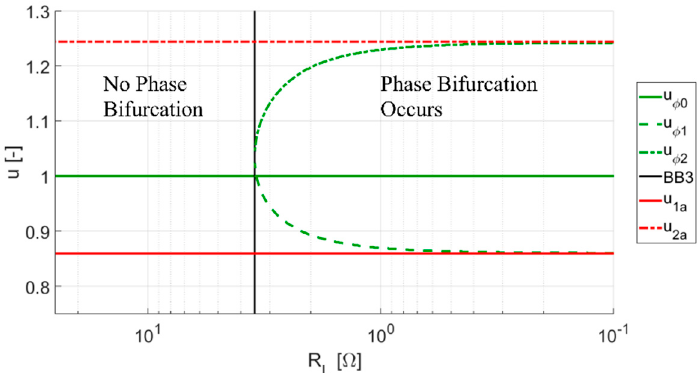
Figure 2. The course of bifurcation with decreasing load resistance R L . The normalized frequency u 0 corresponds to the resonance frequency f 0 , while u ϕ 1 and u ϕ 2 with higher ZPA frequencies f ϕ 1 and f ϕ 2 , respectively. Their asymptotes are u 1 a and u 2 a ,